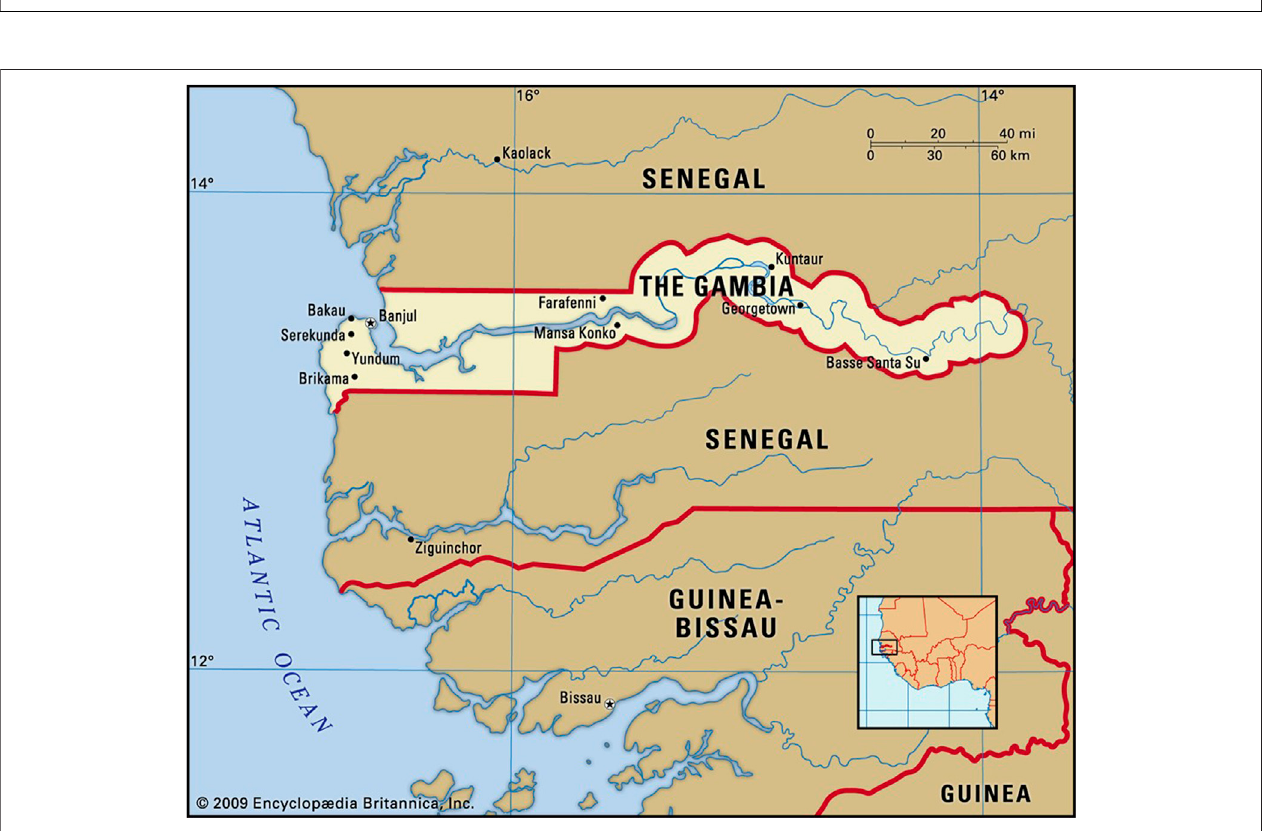
FIGURE5| MapshowingthelocationofBrikamainTheGambia,WestAfrica(BycourtesyofEncyclopædiaBritannica,Inc.,copyright2009;usedwithpermission).